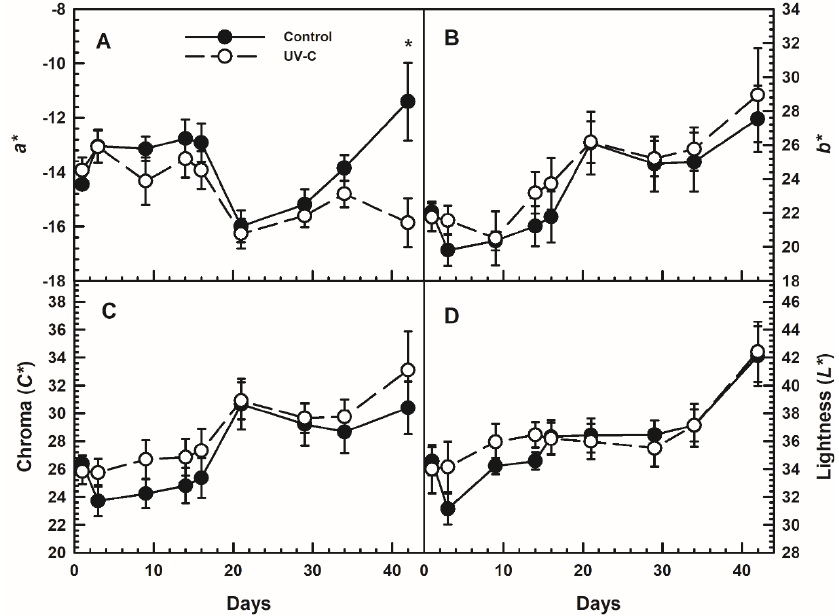
Figure 3. Leaf colour parameters ( a *; A ), ( b *; B ), (chroma; C ) and (lightness; D ) of P. × hortorum stem cuttings irradiated with 1 kJ m − 2 or left nonirradiated (controls) over a 6-week period. Data ( n = 30) are means per treatment per day ±S.E. Asterisks indicate significant differences between treatment means at p = 0.05. No differences in C* were recorded between the irradiated and the nonirradiated cut- tings. Lightness ( L* ) increased throughout the 42-day evaluation period for both the UV- C-irradiated and the nonirradiated samples (Figure 3D). L* values ranged from 31.1 to 42.4, but no significant differences were detected between the UV-C-irradiated and the nonirradiated cuttings. The c olour differences (ΔΕ) ranged considerably from the begin- ning to the end of the experiment (Figure 4). ΔΕ values were at 8.5 and 10.6 on day 3 and at 89.4 and 104.0 on day 42, for the control and the UV-C-treated cuttings, respectively. However, these differences were not significant at the p = 0.05 level.